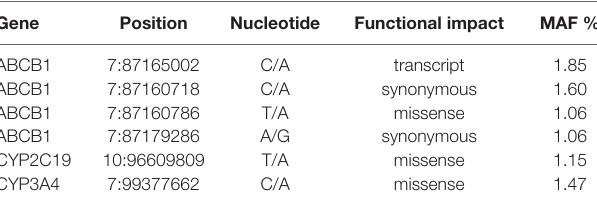
TABLE 3 | Selected novel variants predicted as deleterious. 1